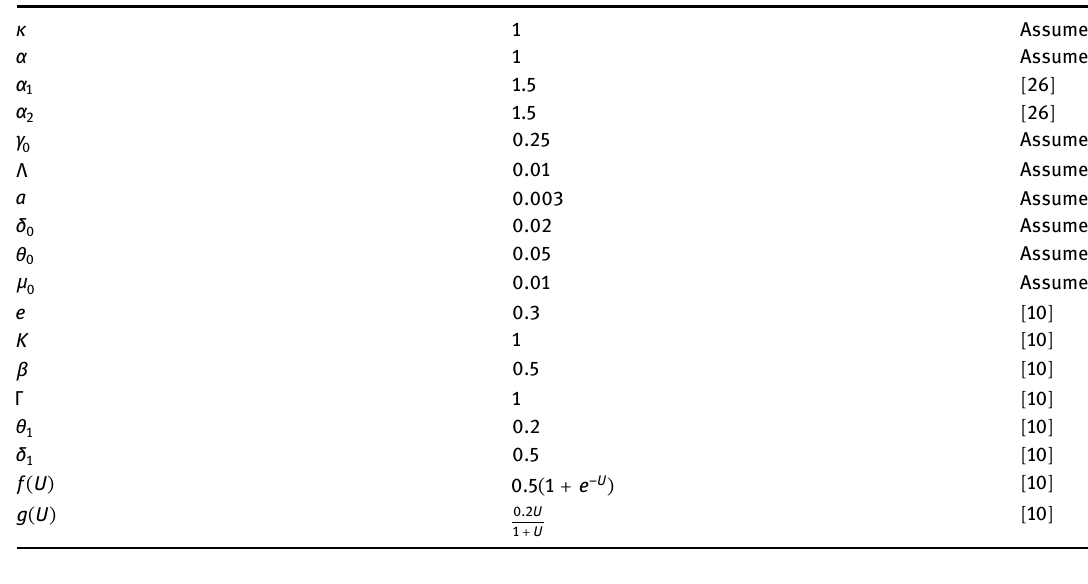
Table 2: Values of the parameters used for simulations Parameter